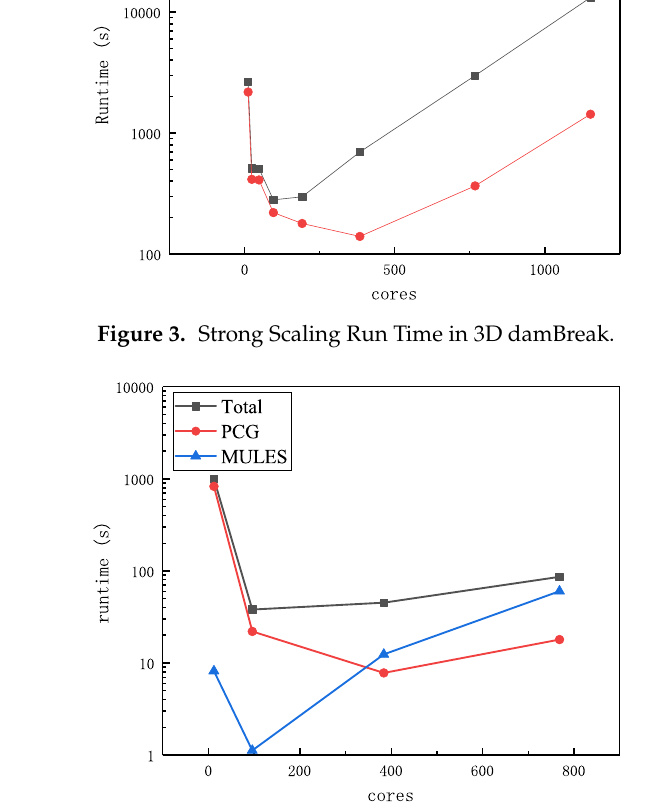
Figure 4. Runtime of Multidimensional Universal Limiter for Explicit Solution (MULES) and Preconditioned Conjugate Gradient (PCG) on different number of cores (12, 96, 384, 768) in damBreak case. The details of damBreak will be shown in Section 5. The gray line means the total runtime of interFoam to solve a damBreak case, and the red one and blue one respectively record the runtime of MULES and PCG. Table 1. Results of tests on a head-form case. The OF-opt means optimized OpenFOAM Runtime in Head-Form Case (s).